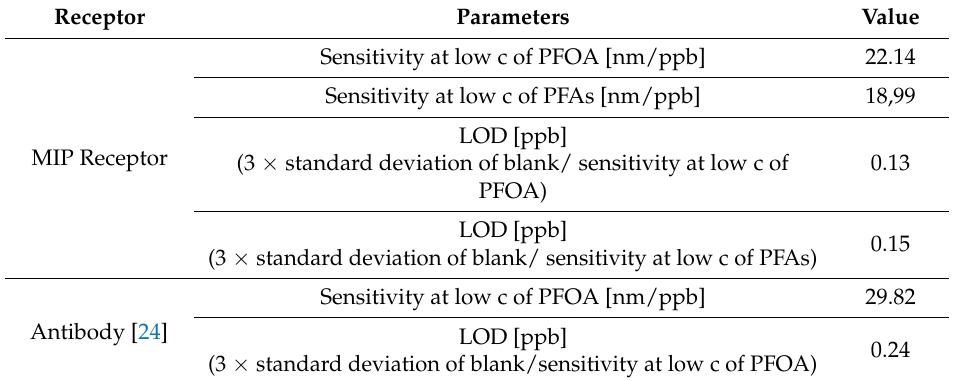
Table 2. PFOA and PFAs detection in water by an SPR-POF-MIP sensor and, for comparison, PFOA detection by [24] (an SPR-POF sensor with a